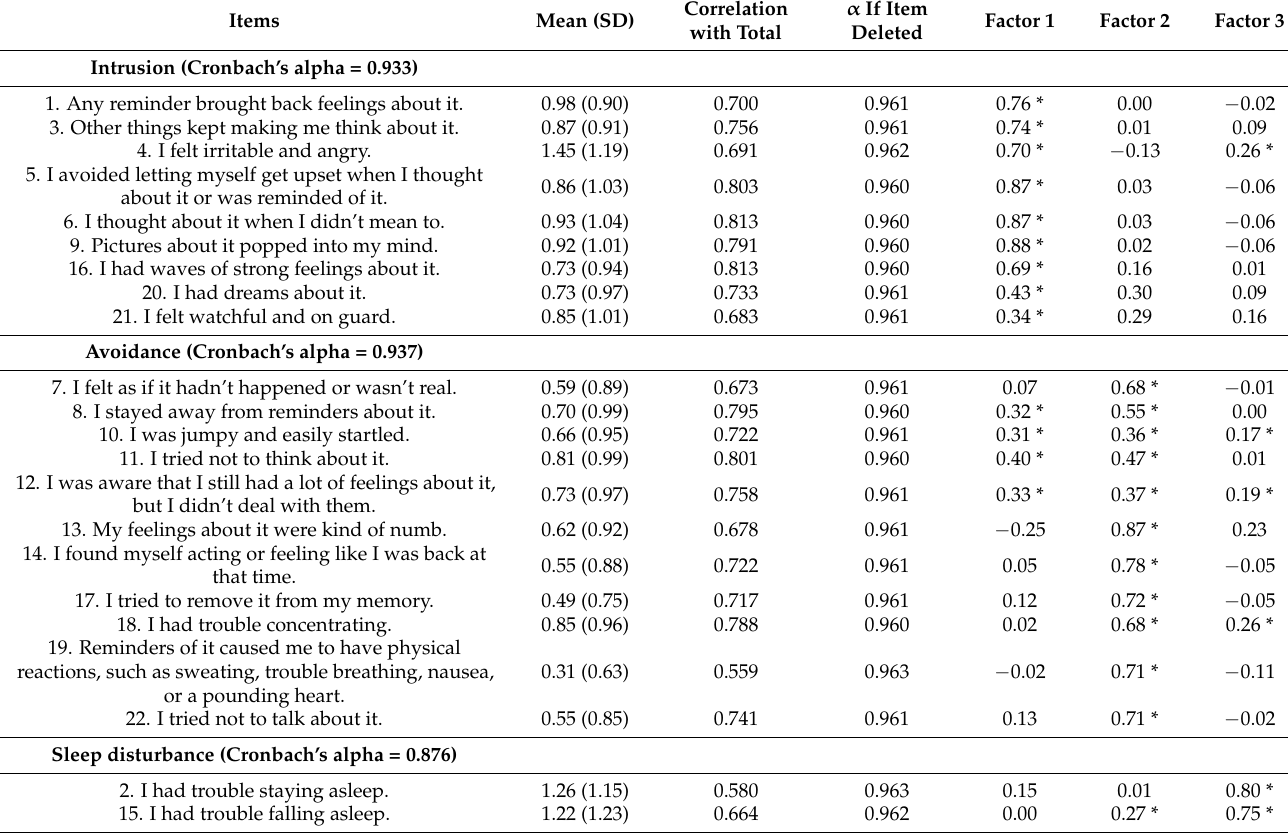
Table 3. The modified model based on exploratory factor analysis.